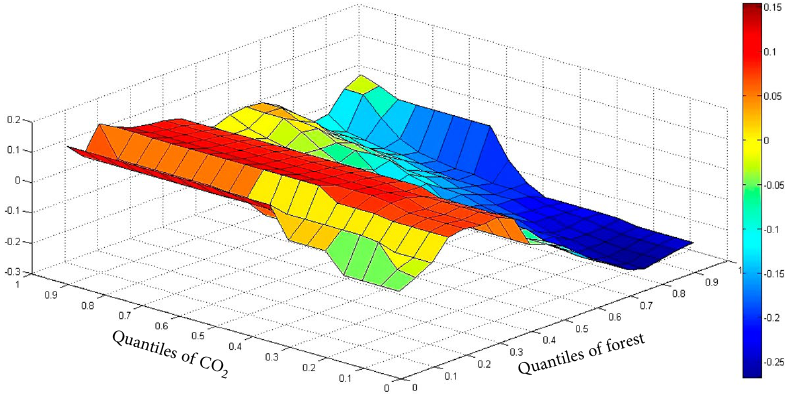
Figure 2. Quantile on quantile regression estimation for